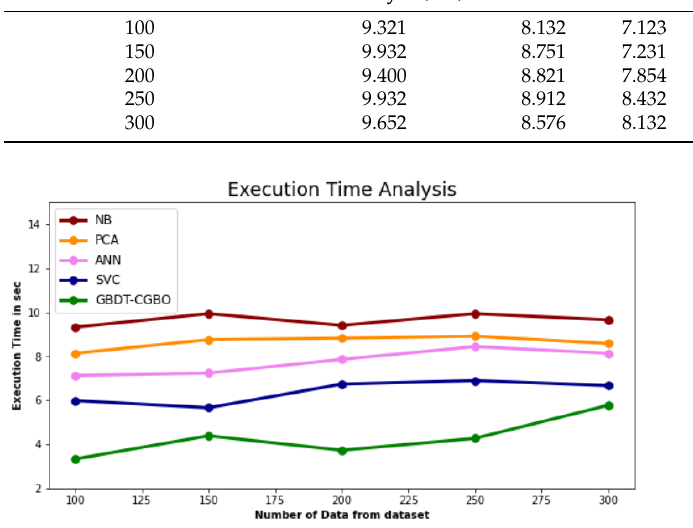
Figure 6. Execution Time Analysis of GBDT-CGBO method with existing system.